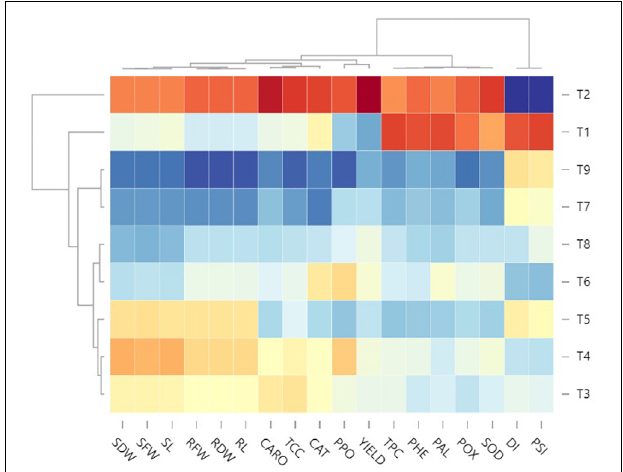
FIGURE 7 | Standard optimized dendrograms and the associated ordered heatmap of standardized data of disease, growth, physio-chemical and yield attributes in nine treatments. BS-01, Bacillus subtilis ; AS, Alternaria solani ; NPK, nitrogen, phosphorus, and potassium; Zn, Zinc. T 1 , − ve control (without inoculation of AS); T 2 , +ve control (with AS inoculation); T 3 , BS-01 + AS; T 4 , Zn (2X) + AS; T 5 , BS-01 + Zn (2X) + AS; T 6 , NPK + AS; T 7